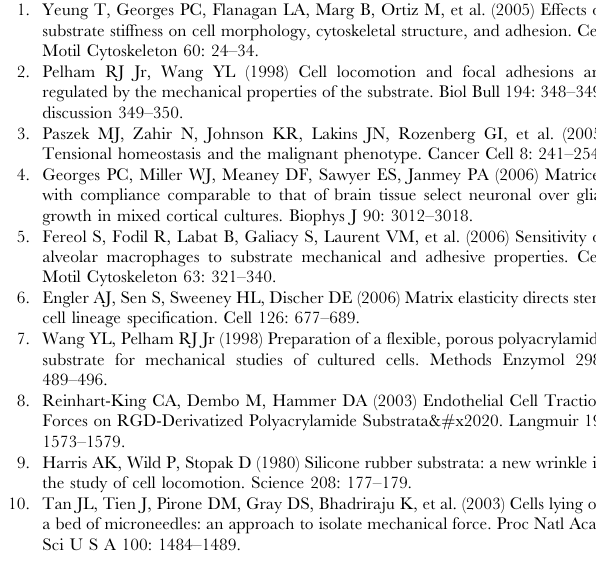
Figure S3 Axial ratio is dependent on fibrinogen concentration but independent of distance to the nearest cell. The axial ratio of neighboring hMSCs were analyzed as a function of distance to the nearest cell on four substrates: 1, 2, and 8 mg/ml fibrin as well as 16 kPa fibrinogen coated polyacrylamide. Reported as mean 6 SE, n =3, at least 10 cells per